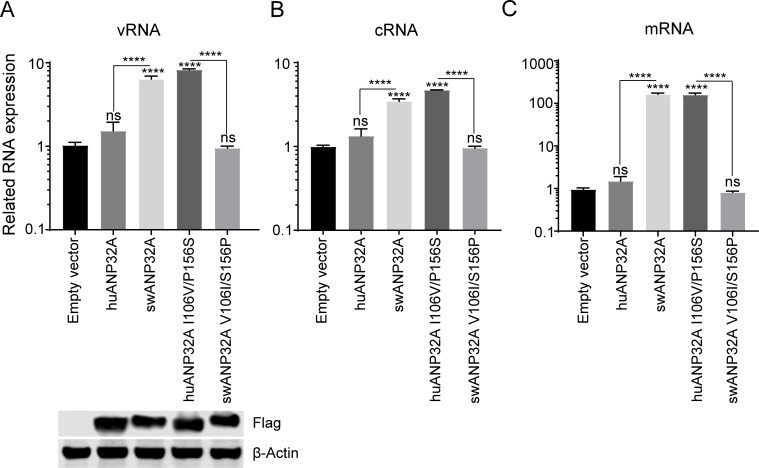
Effect of the ANP32A 106/156 sites on avian influenza viral polymerase transcription and replication.DKO cells were transfected with the minireplicon system of avian influenza virus H7N9ZJ13, and a minigenome reporter pHH21-huPolI-vLuc, together with different ANP32A mutants or empty vector. Total RNA of DKO cells was extracted at 24 h post-transfection and reverse transcription was performed, followed by quantitative PCR (qRT–PCR) for vRNA (A), cRNA (B), and mRNA (C) from the luciferase gene. Luciferase RNA levels were normalized to the β-actin RNA level (means SD from three independent experiments. NS = not significant, ****P < 0.0001; all by one-way ANOVA followed by a Dunnett’s test). The expression of different ANP32A mutants were evaluated by Western blotting.